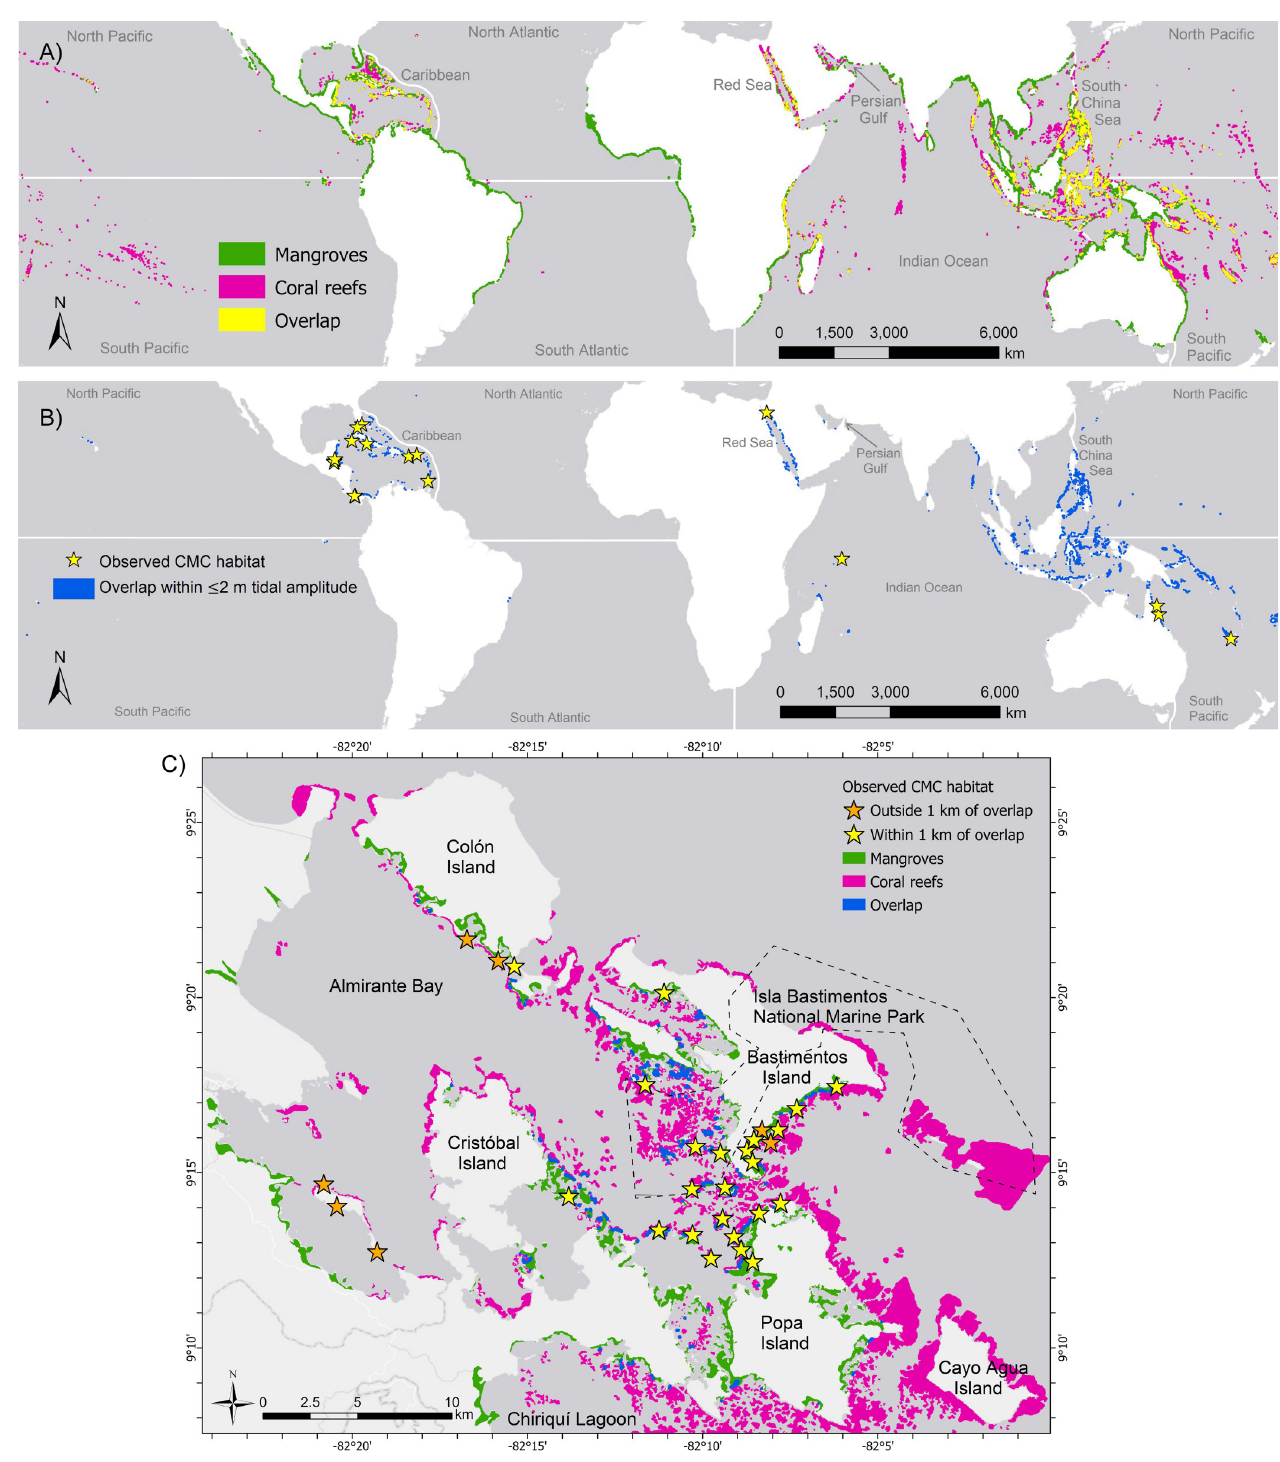
Fig 7. Potential global extent of coexisting mangrove-coral (CMC) habitats. (A) Global distribution of mangroves (green) and coral reefs (pink), showing overlap (up to 10 m annual average tidal amplitude) of their extents (yellow). (B) Microtidal overlap ( � 2 m annual average tidal amplitude) wherein mangrove roots are fully submerged during both high and low tide. Stars represent CMC habitat locations obtained from literature review. (C) Ground-truthing of CMC model to validate accuracy based on crosschecking the output with known CMC habitat locations in the Bocas del Toro Archipelago. The model was able to predict 77% of our known CMC habitats within 1 km of the overlap